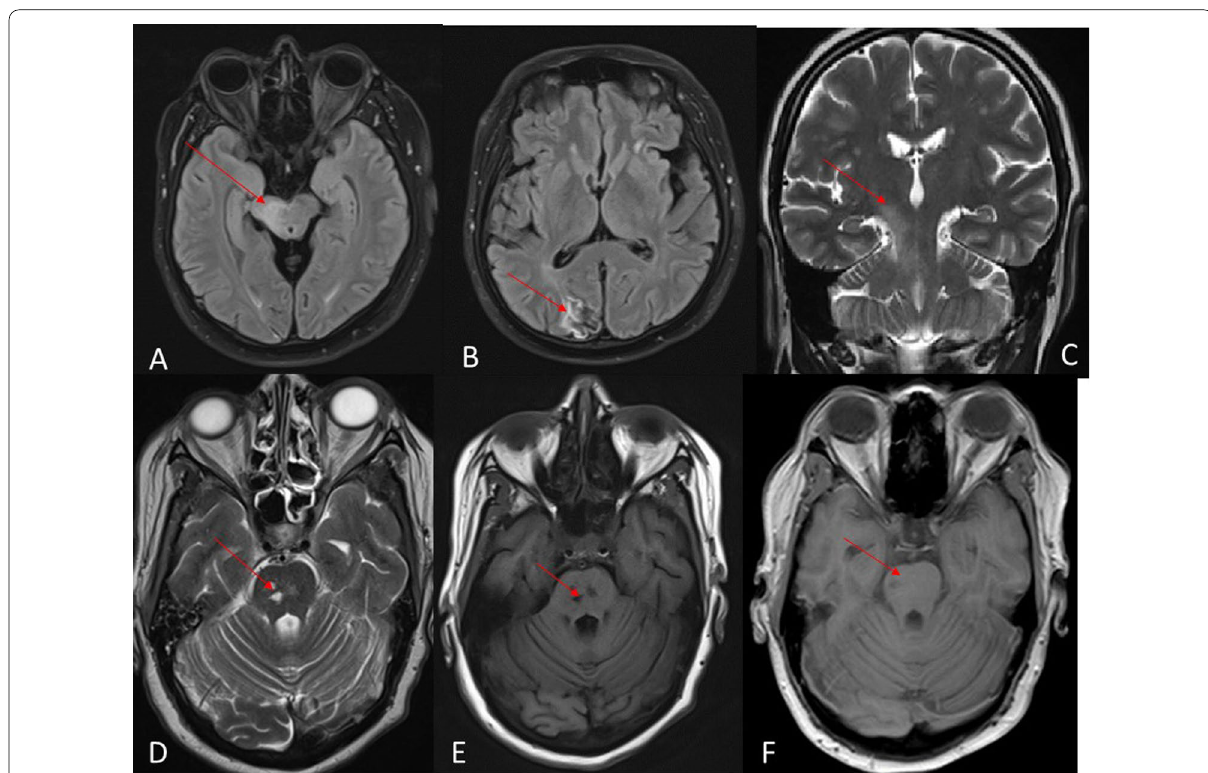
Fig. 1 Magnetic resonance imaging (MRI) brain of patient 1 ( A – C ). A , B Fluid-attenuated Inversion Recovery (FLAIR) axial images showing hyperintense lesion in midbrain and gliosis in right occipital area (red arrows); C coronal T 2 image showing cascade sign (red arrow). MRI of patient 3 ( D – F ), ( D , E ) axial T 2 and T 1 image showing pontine base discrete hyperintense and hypointense lesion (red arrow); F axial T 1 image showing decrease in lesion with